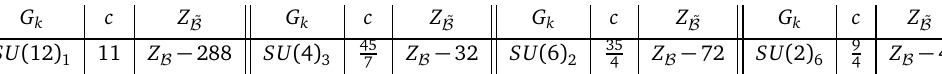
Table 5: List of A-type WZW models satisfying the supersymmetry conditions after the fermion- ization. The four theories in this table have the non-anomalous (cid:90) the center symmetry. The difference between Z B and Z It suggests that their fermionic theories in the correspondence have supersymmetric Ramond vacua.